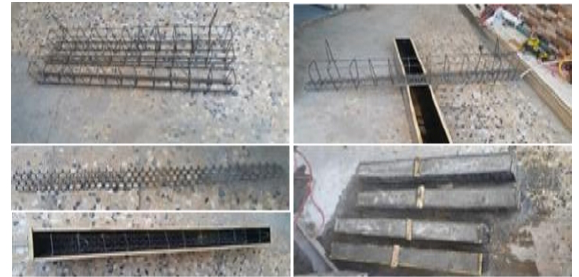
Fig. 5. Geo-grid Layer, Details of Steel Reinforcement, and Samples after Molding